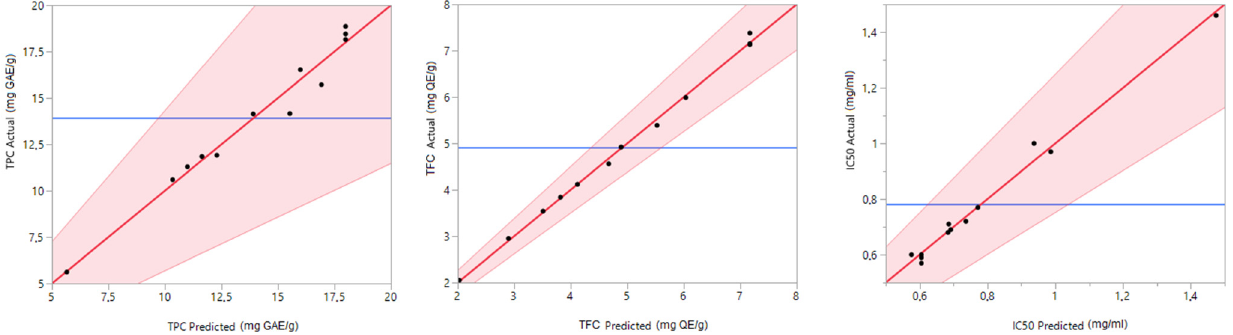
Figure 3. Curves of observed values versus predicted ones.